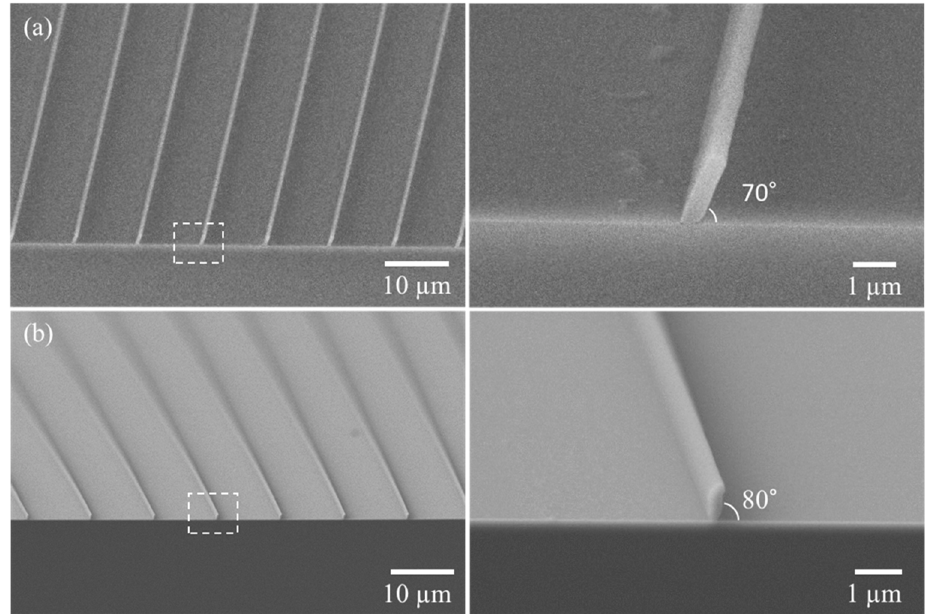
Figure 5. Oblique sub-micron structures and the magnified single structure of 10 µ m period at ( a ) 20°, ( b ) 10°.